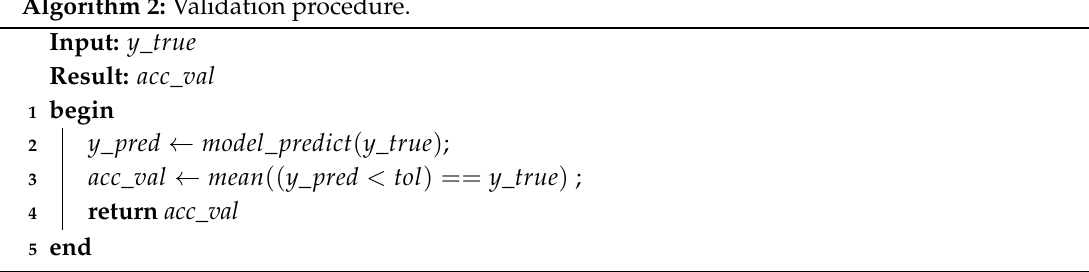
Algorithm 2: Validation